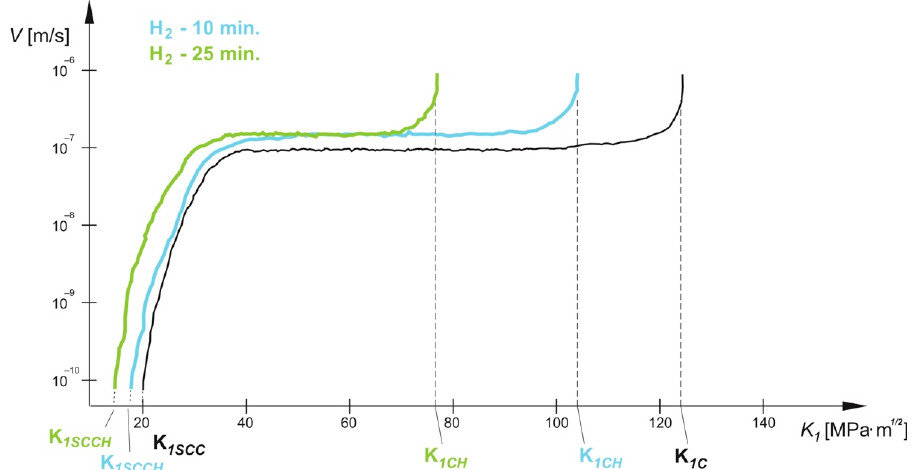
Figure 5. The dependence of the crack propagation rate on the value of the stress intensity factor K 1 for not-hydrogenated and hydrogenated (H 2 ) 1050A alloy—time of the hydrogenation: 10 and 25 min. K 1SCC —nucleation and growth of a stress corrosion crack; K 1SCCH —nucleation and growth of a stress corrosion crack after hydrogenation; K 1C —material separation; and K 1CH —material separation after hydrogenation.